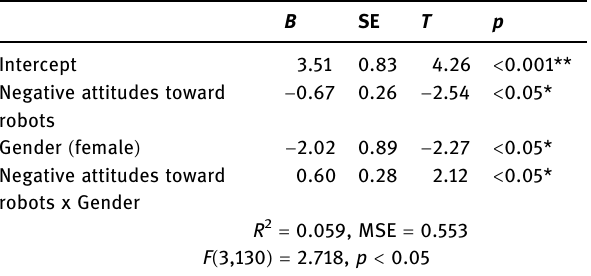
Robots ’ tasks at